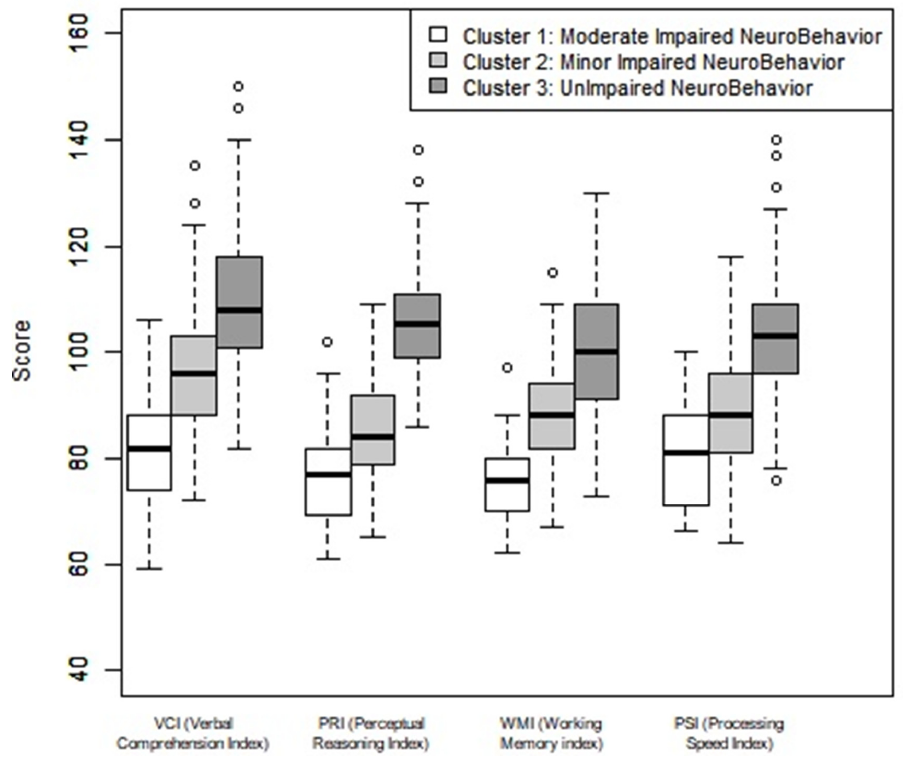
Figure 2. Neuropsychological evaluation of the four WISC IV indices by cluster. Note: Verbal comprehension index (VCI), perceptual reasoning index (PRI), working memory (WMI), and processing speed index (PSI). Average = 100, 1 SD = 15.